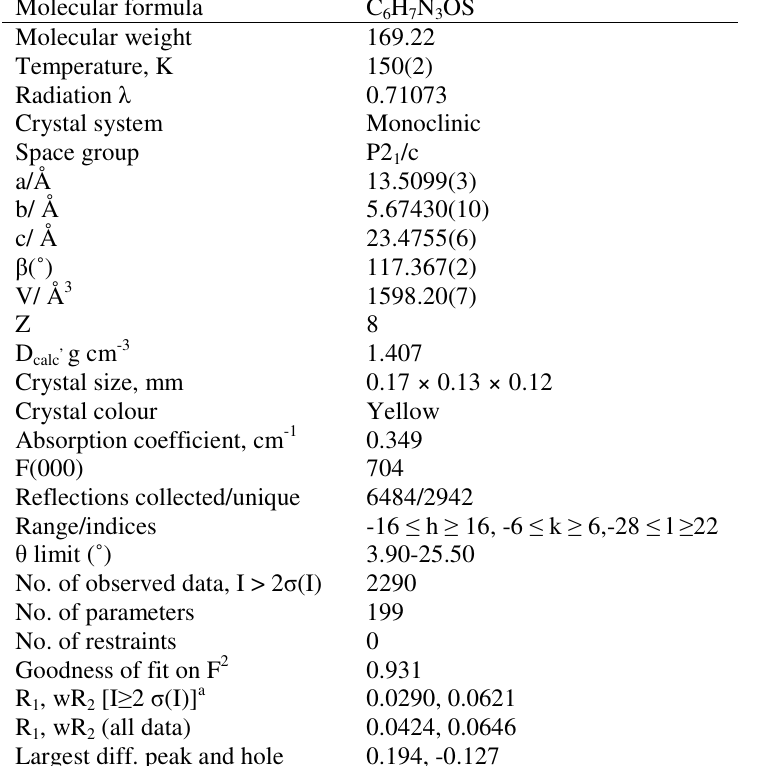
H N OS at 6 7 3